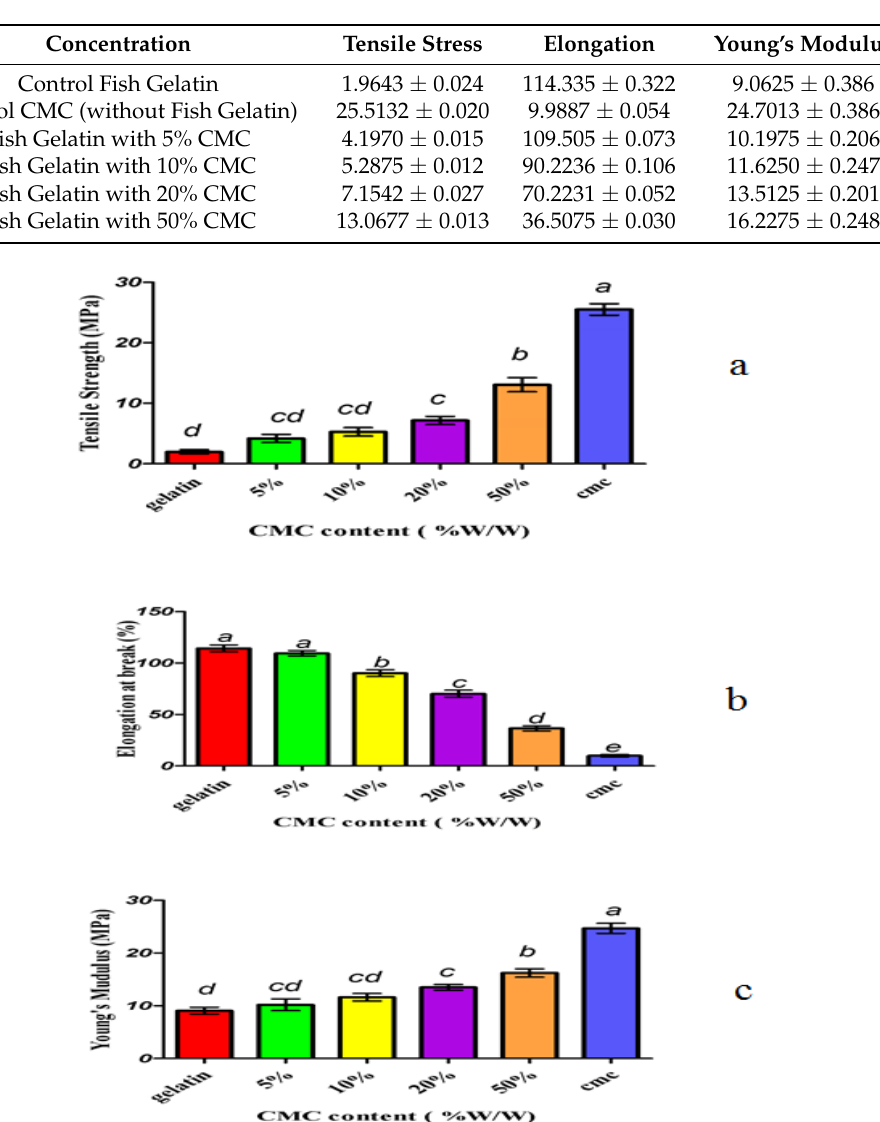
Table 1. Results of mechanical properties of cold water fish gelatin films with added Carboxymethyl Cellulose (CMC).